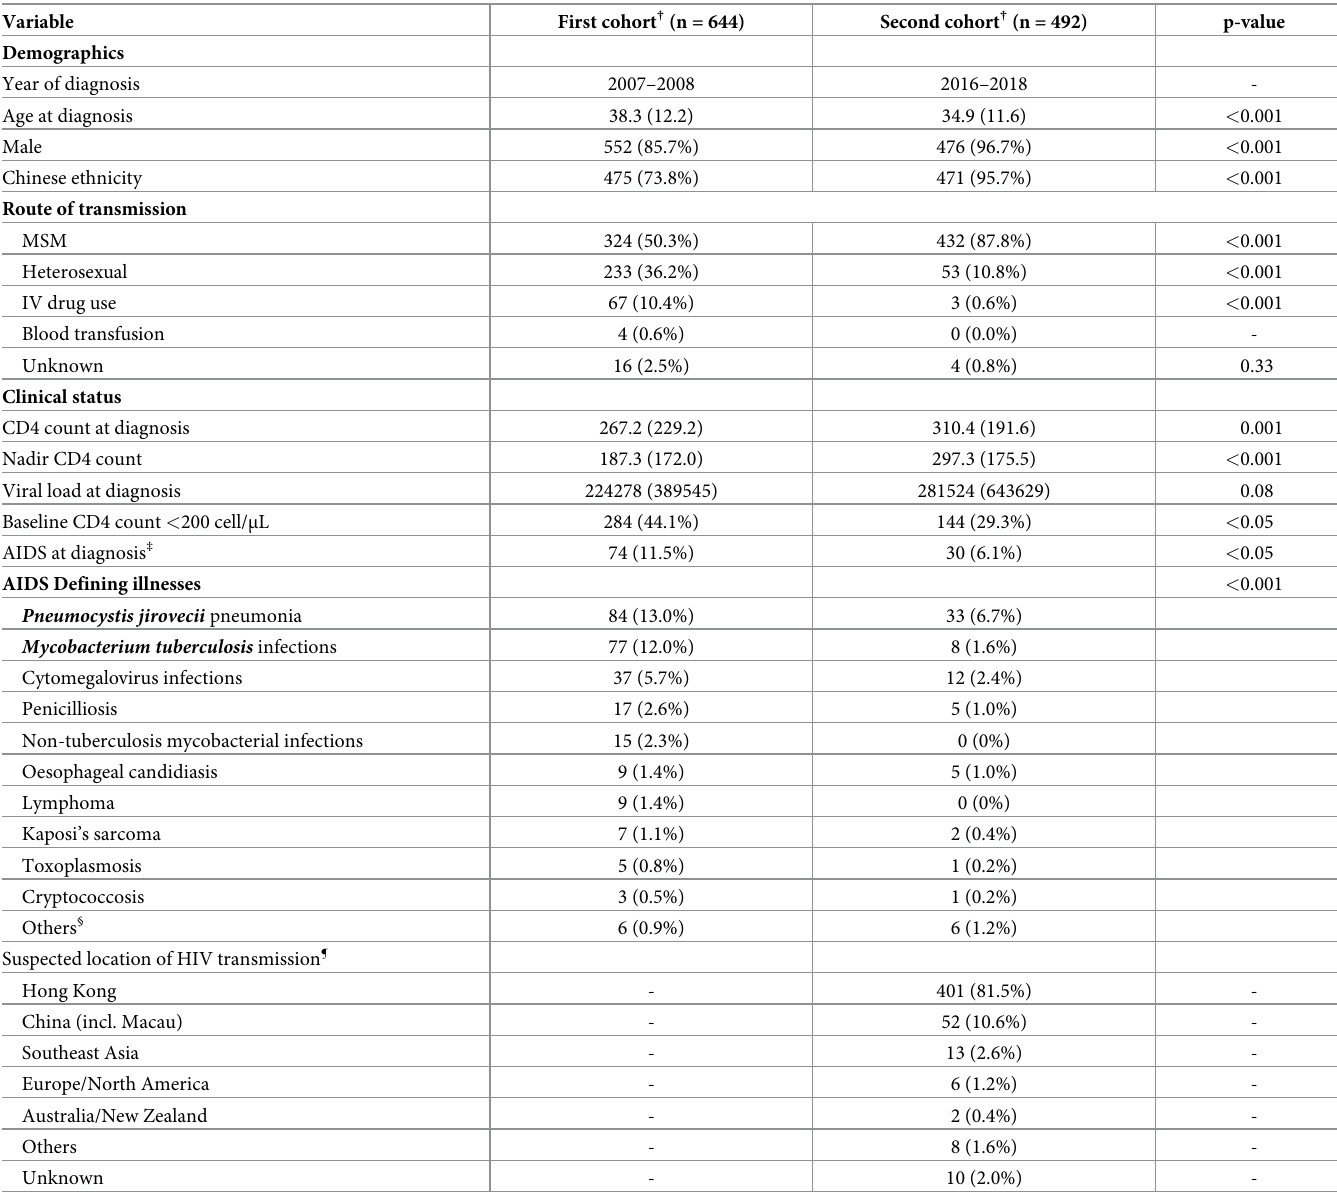
Table 1. Characteristics of newly diagnosed HIV patients in the first (years of diagnoses 2007–2008) and second cohort (years of diagnoses